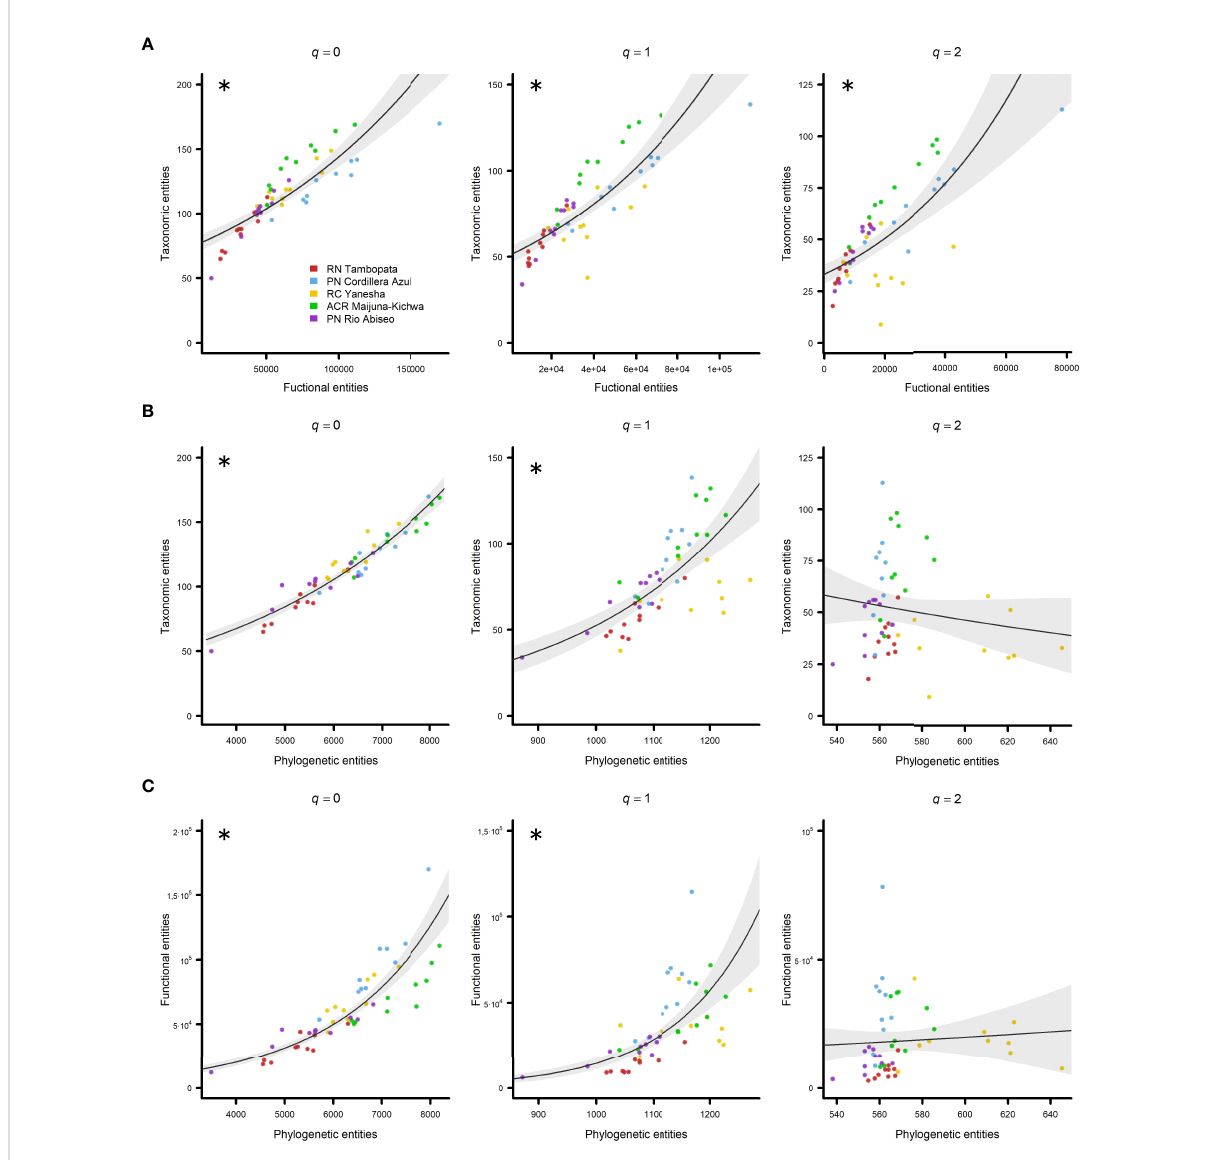
FIGURE 2 Relationship between diversity attributes in all fi ve regions studied in Western Amazonia represented by negative binomial generalized linear models (GLMs) with 95% con fi dence intervals. (A) Taxonomic vs. functional entities, (B) taxonomic vs. phylogenetic entities, and (C) functional vs. phylogenetic entities. Hill numbers were considered as diversity indexes: q = 0 (left column), q = 1 (central column), and q = 2 (right column). Regions are represented by different colours (see the legend). Signi fi cant pseudo R-squared ( pR 2 ) v alues are marked with